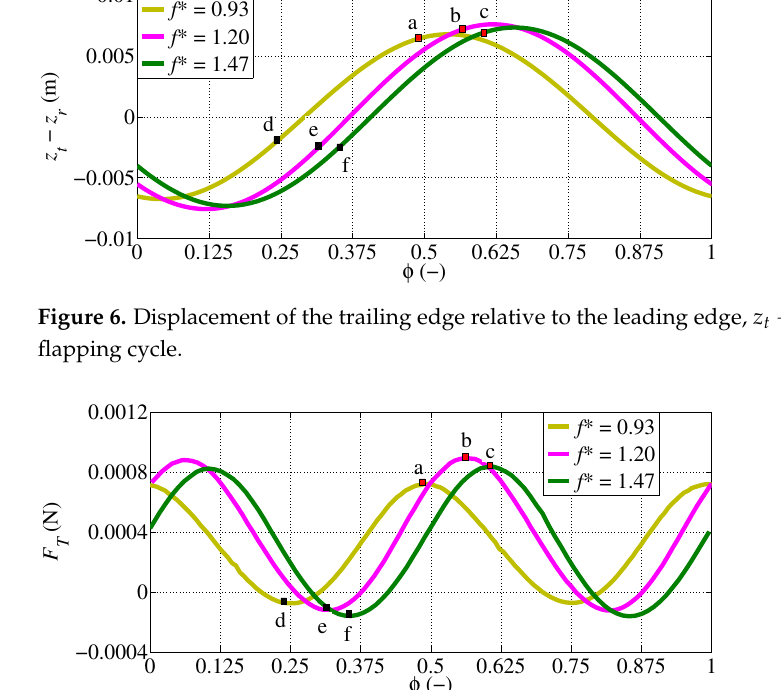
Figure 7. Instantaneous thrust variation with different f ∗ in a flapping